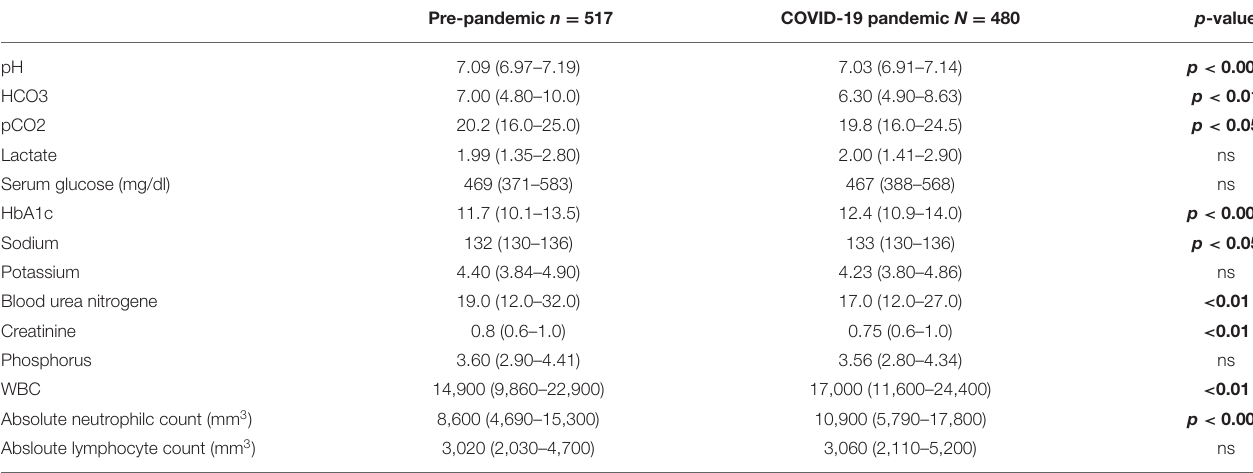
TABLE 2 | Laboratory features of children with DKA during pre-pandemic and COVID-19 pandemic period.